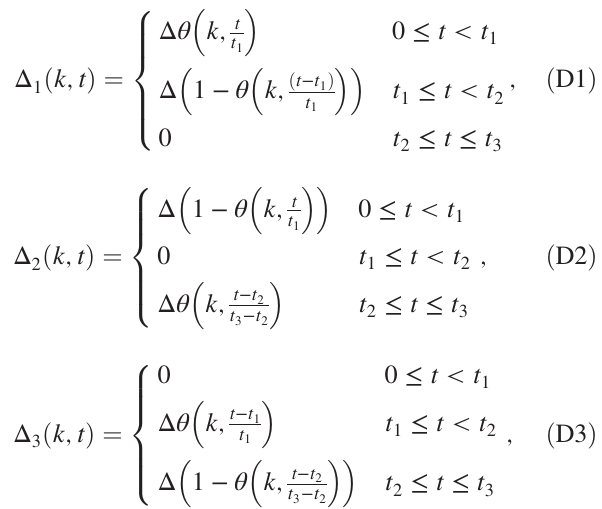
FIG. 14. Transition probability P without dissipation. Here, k ¼ 0 , 1, 2, 3 refers to the number of vanishing time derivatives of the Hamiltonian at each turning point.